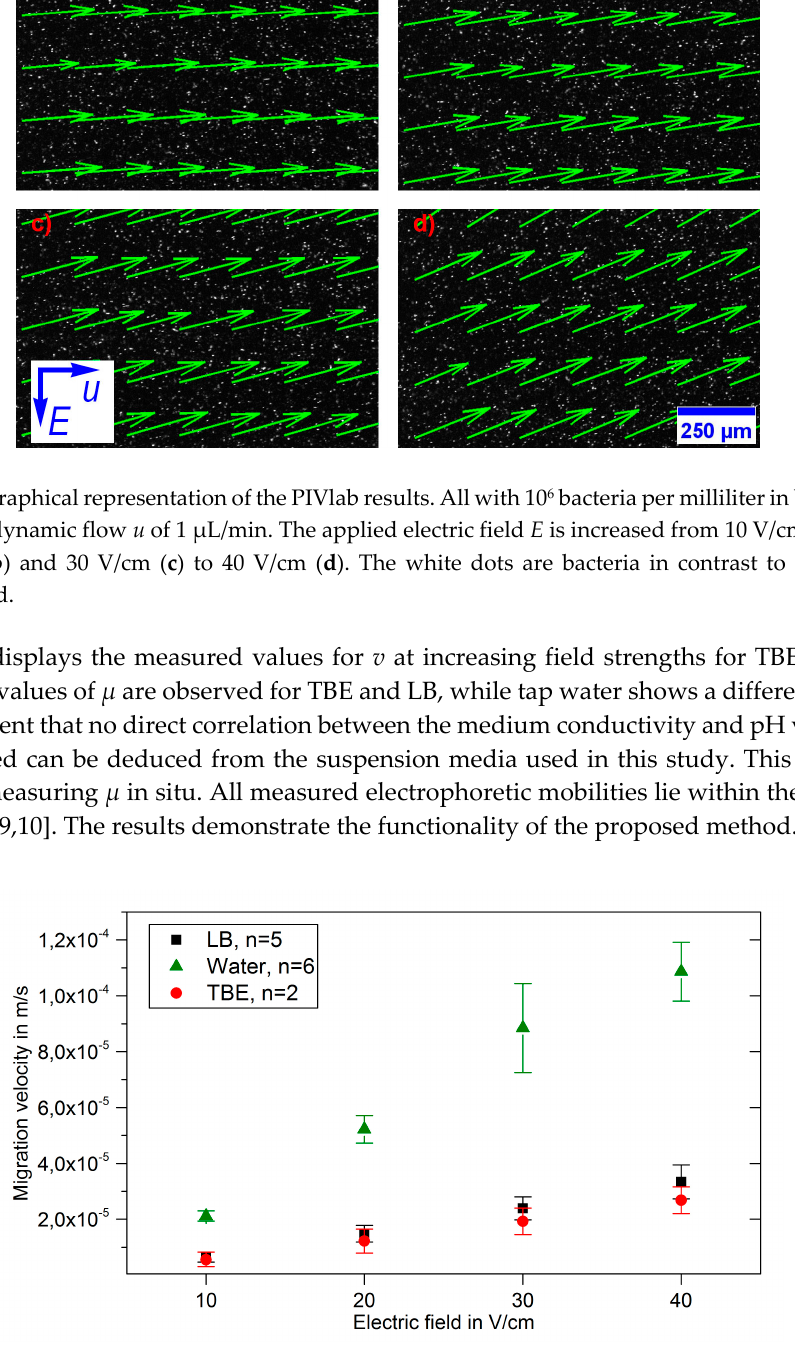
Figure 3. Comparison of the measured migration speed in different media. All are averages of measurements with fresh cultures on different